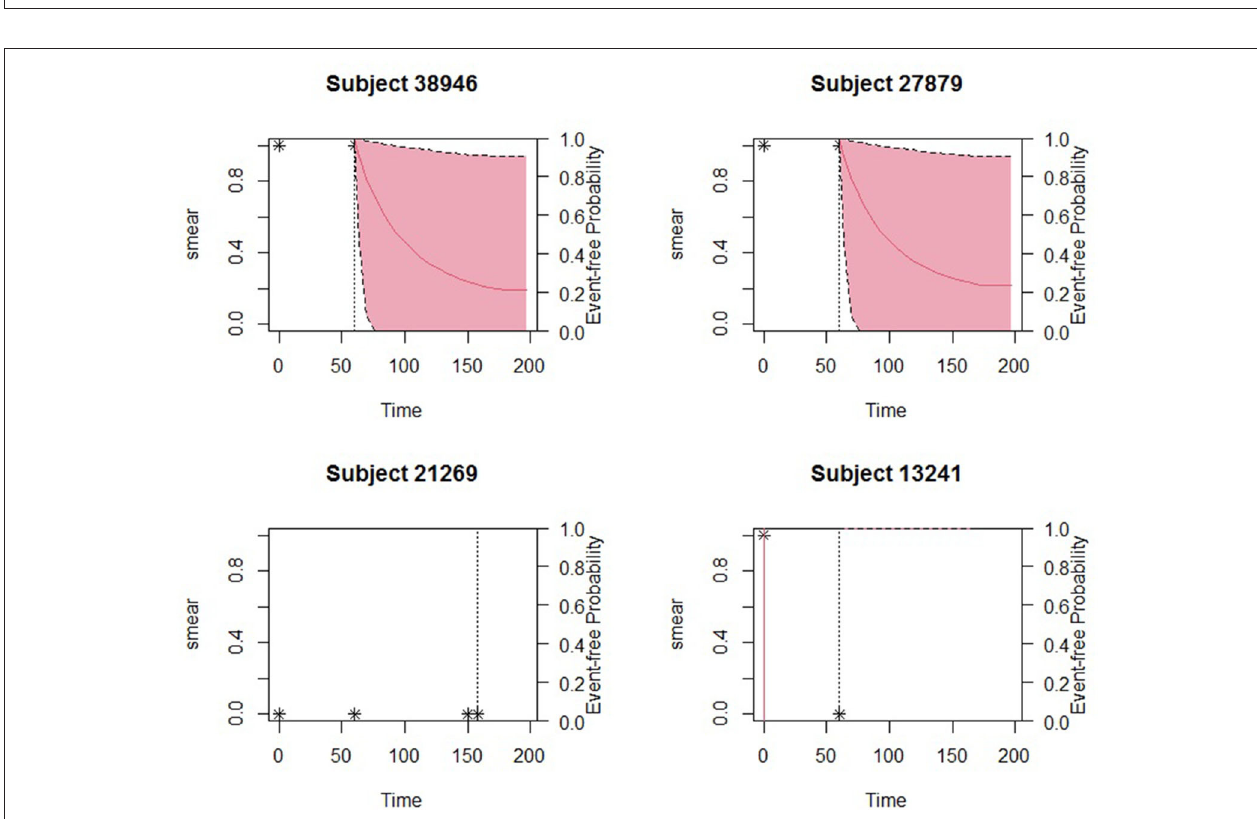
FIGURE 2 | Predicted survival probabilities for patients 27879, 38946, 21269, and 13241. Solid red line is the mean of 2,000 MCMC samples. Dashed lines are the 2.5 and 97.5% percentiles range of the 2,000 MCMC samples. The dotted vertical line represents the time of prediction t